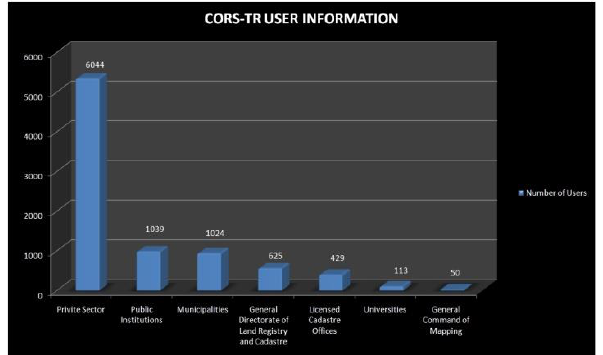
Figure 4. CORS-TR System User